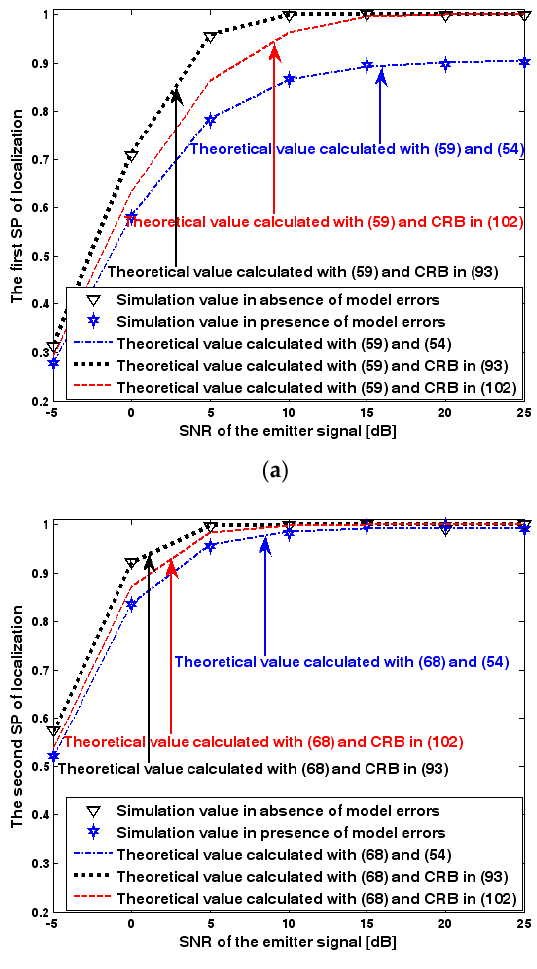
Figure 16. SP of localization as a function of SNR of the emitter signal. ( a ) The first SP of localization as a function of SNR of the emitter signal. ( b ) The second SP of localization as a function of SNR of the emitter signal.